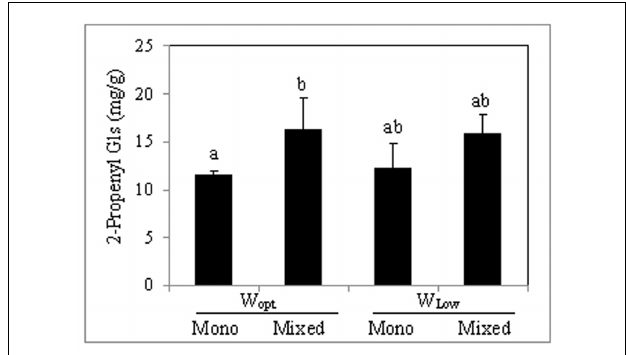
FIGURE 2 | 2-Propenyl glucosinolate concentration in B. carinata leaves (mg/g dry weight). For treatment description, see Table 1 . Shown are the mean values ( n = 4) obtained for each treatment + standard deviation. Bars followed by the same letter are not significantly different (Tukey HSD test; P ≤ 0.05).